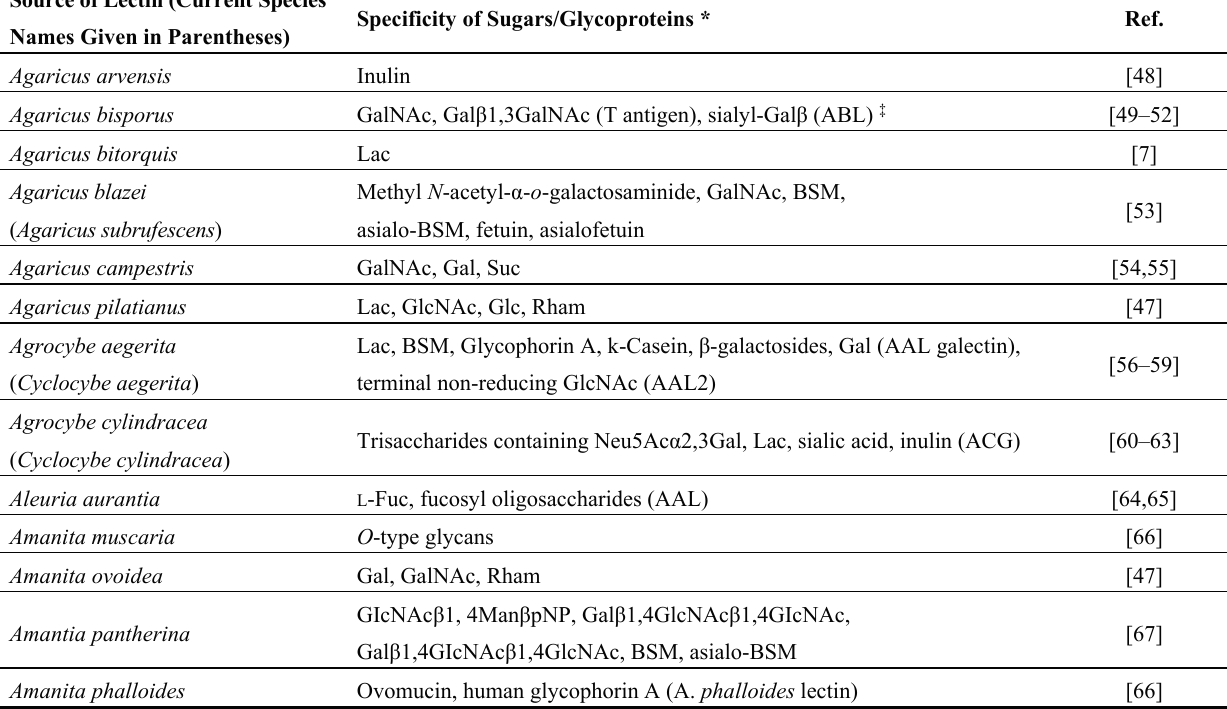
Table 1. Mushroom lectins and their